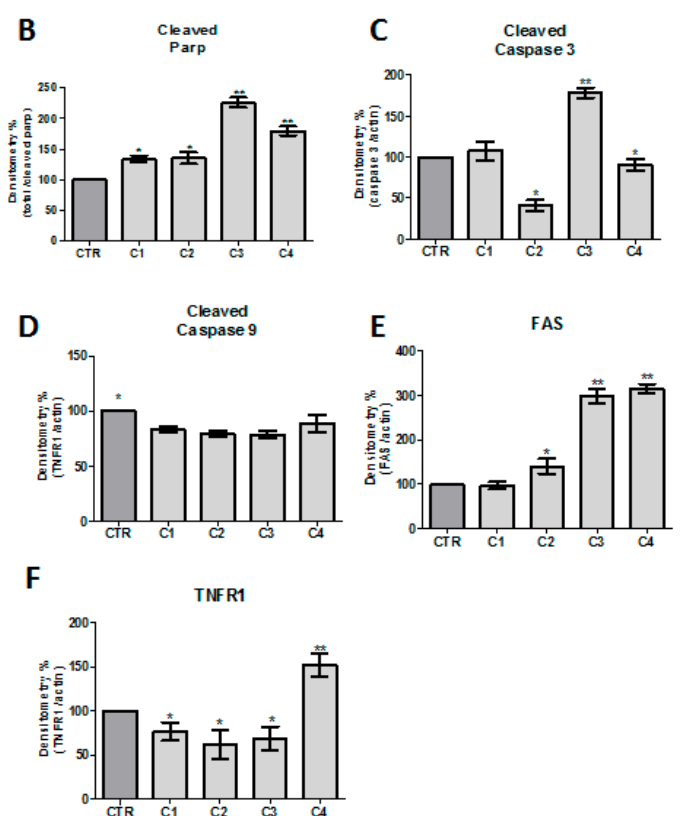
Figure 4. Effect of crude extract (C3) and fractions (C1, C2 and C4) of T. guianensis on intracellular signaling pathway activation in HN13 cells. HN13 cell lines were incubated with compounds (IC 50 values) for 24 h. ( A ) Western blot, using the antibodies of anti-human PARP (Full Length: 116 kDa and cleaved: 89 kDa), Caspase 3 (Full Length: 35 kDa), Caspase 9 (cleaved: 19 kDa) Fas (40 kDa) and TNFR1 (55 kDa) and Actin (45 kDa); ( B – F ) densitometric analysis of Western blot data of the four proteins. Bars results are expressed as the means ± SD. * p < 0.05; ** p < 0.01.